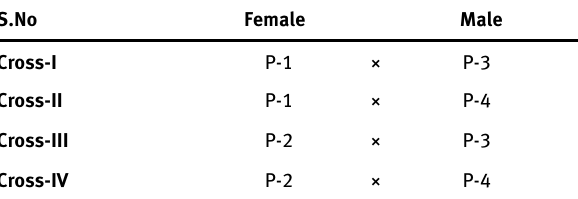
hybrids after crossing inbred lines Table 2: F 1